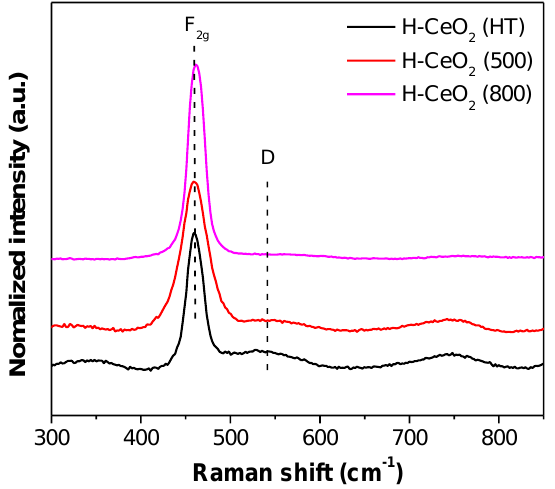
Figure 4. Raman spectra of H-CeO 2 supports.